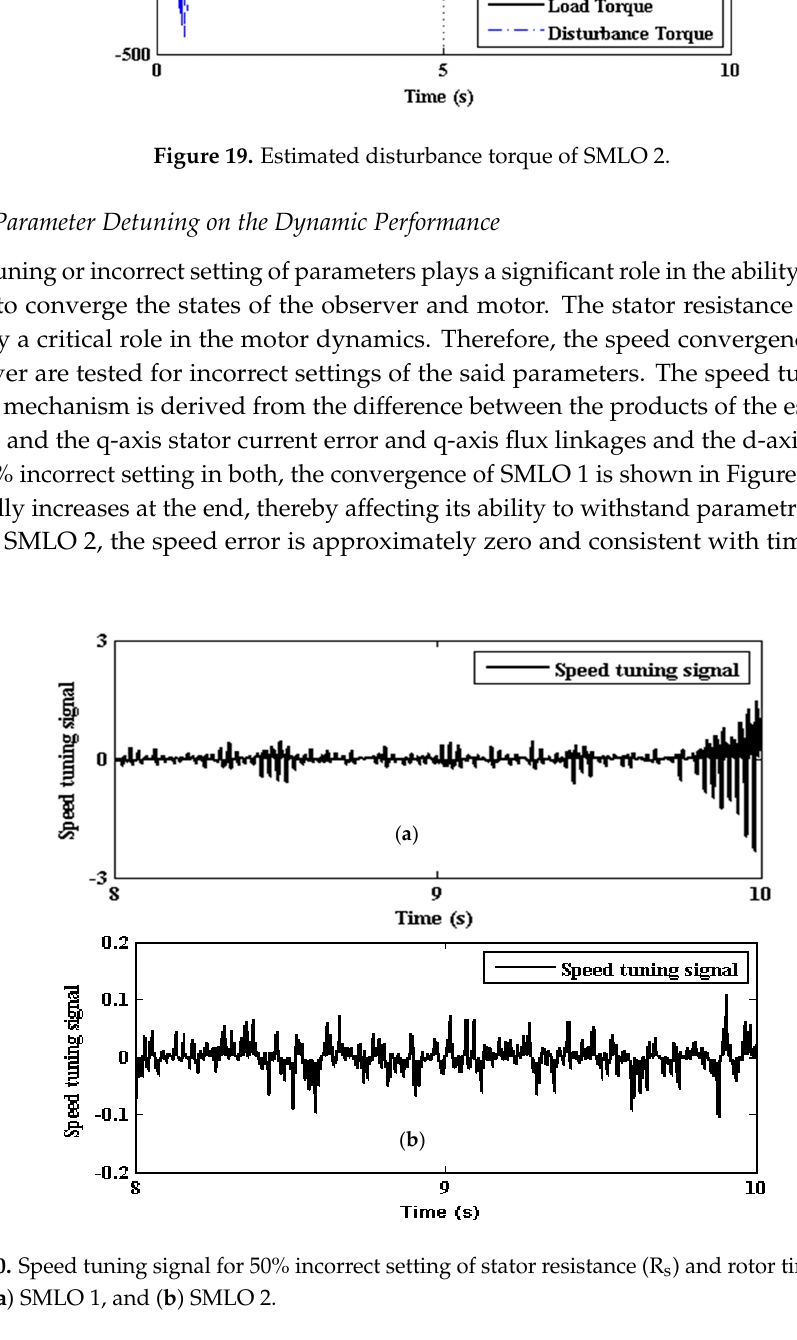
Figure 19. Estimated disturbance torque of SMLO 2.